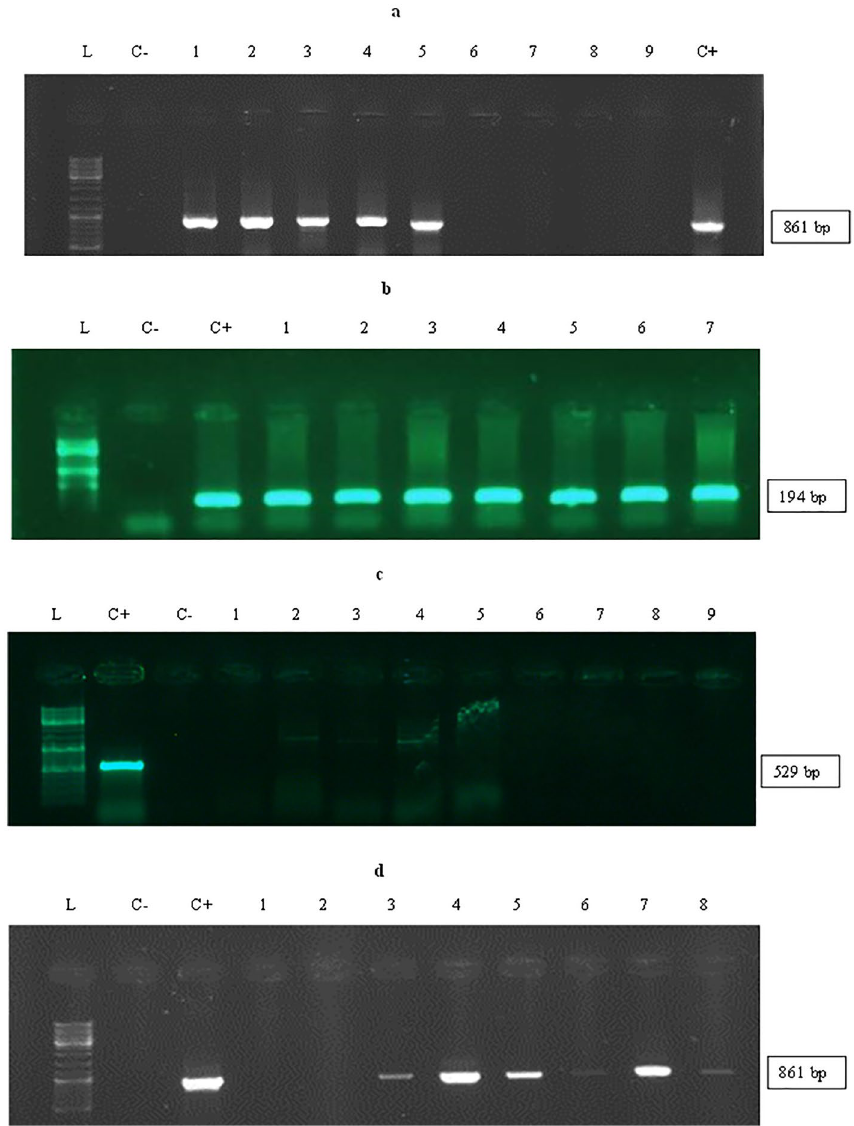
Figure 3. Confirmation of the transgenic lines. PCR amplification of MAP30 ( a ) and rolB ( b ) using DNA template, and MAP30 ( c ) using cDNA, template derived from N. tobacco hairy root lines. Lane L, Ruler 1-kb DNA ladder Mix (Thermo Fisher Scientific, Germany). ( a ) Lane 1: negative control (water), lanes 2–6: transgenic hairy roots samples, lane 7–10: non-transgenic hairy root samples, lane 11: positive control (transformed A. rhizogenesis DNA); ( b ) lane 1: negative control (water), lane 2: positive control (transformed A. rhizogenesis DNA), lanes 3–6: transgenic hairy roots samples, lane 7–9: non-transgenic hairy root samples; ( c ) lane 1: negative control (water), lane 2: positive control (transformed A. rhizogenesis DNA), lanes 3 and 4: non- transgenic hairy root samples, lane 5–10: transgenic hairy root